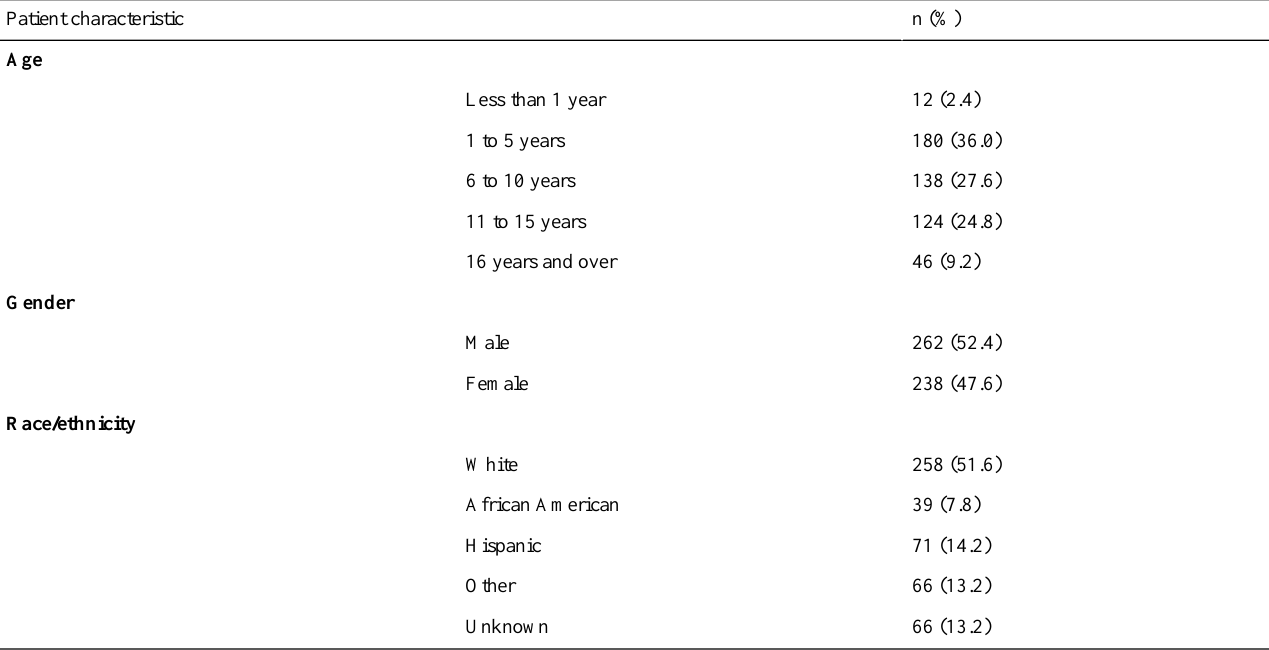
Table 1. Characteristics of index patients (children) in the test sample (n=500).